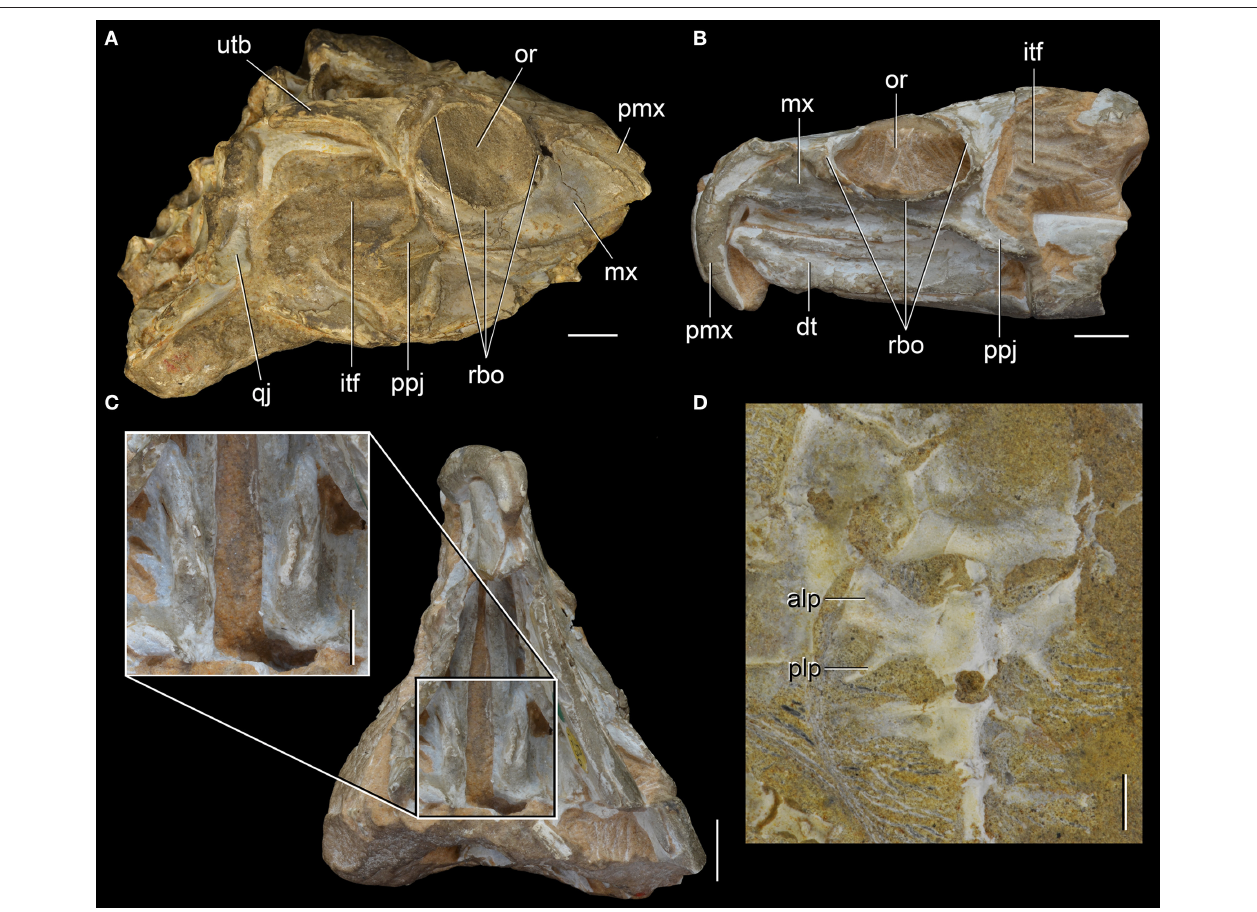
FIGURE 5 | Rhynchosaurus articeps from the Anisian of England. Partial skull (SHYMS 1, lectotype) in right lateral view (A) , referred specimen NHMUK PV R1236 in left lateral (B) and ventral views, with close-up of palatal dental structure (C) , and sacral vertebrae and first caudal of the referred specimen SHYMS 5 in ventral view (D) . Abbreviations: alp, anterolateral process; dt, dentary; itf, infratemporal fenestra; mx, maxilla; or, orbit; plp, posterolateral process; pmx, premaxilla; ppj, posterior process of the jugal; qj, quadratojugal; rbo, raised border of the orbit; utb, upper temporal bar. Scale bars equal 1cm in (A-C) and 5mm in close-ups of (C,D)